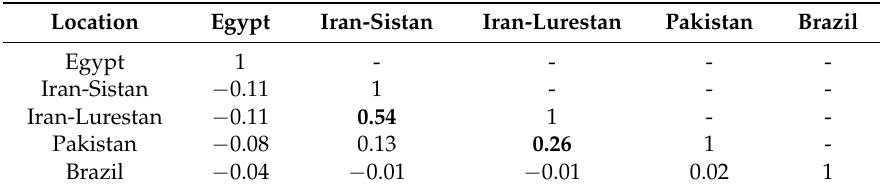
Table 2. Correlation matrix (Pearson) between the locations of sampling based on the chemical composition of the EO of both Egyptian X. strumarium ecospecies and other ecospecies. Location Egypt Iran-Sistan Iran-Lurestan 1 - - - - − 0.11 1 - - - − 0.11 0.54 1 - - − 0.08 0.13 0.26 1 - Brazil − 0.04 − 0.01 − 0.01 0.02 1 Values in bold are different from zero, with a significance level alpha = 0.05.